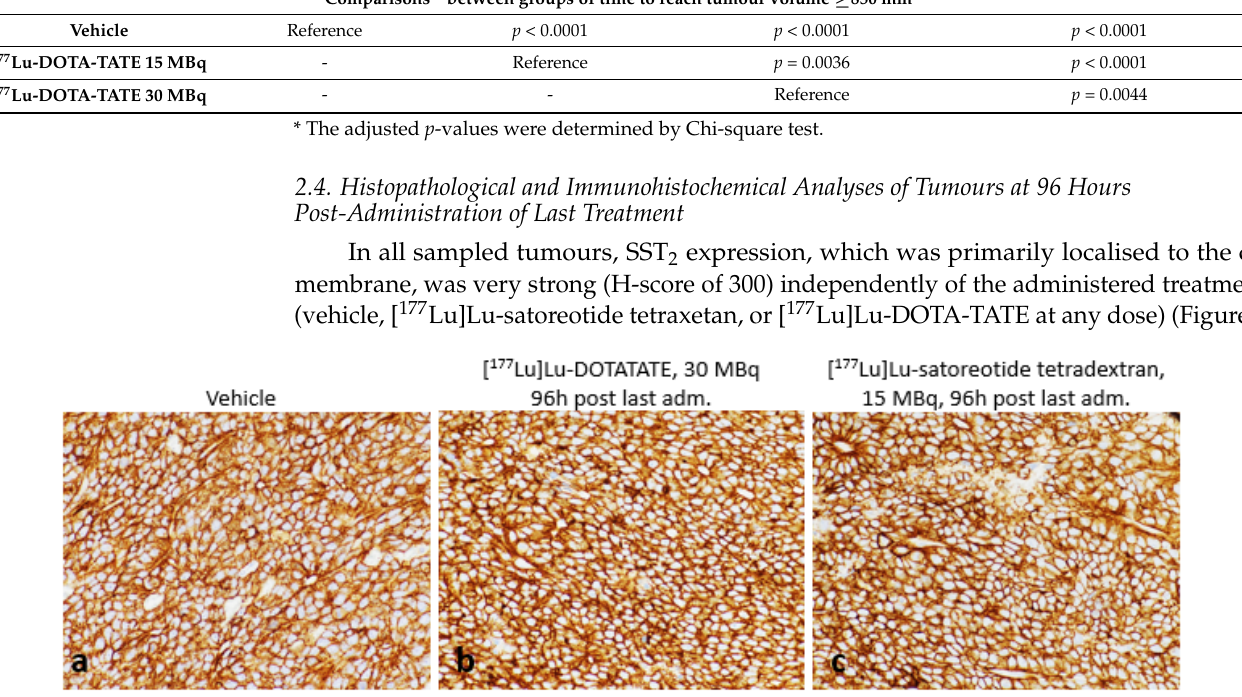
Figure 3. Somatostatin receptor subtype 2 (SST 2 ) expression in tumours. The basal high SST 2 expression ( a ) was not modified by the administered treatments either with [ 177 Lu]Lu-DOTA-TATE ( b ) or [ 177 Lu]Lu-satoreotide tetraxetan ( c ) 96h post last administration. All images were taken using an objective 40.